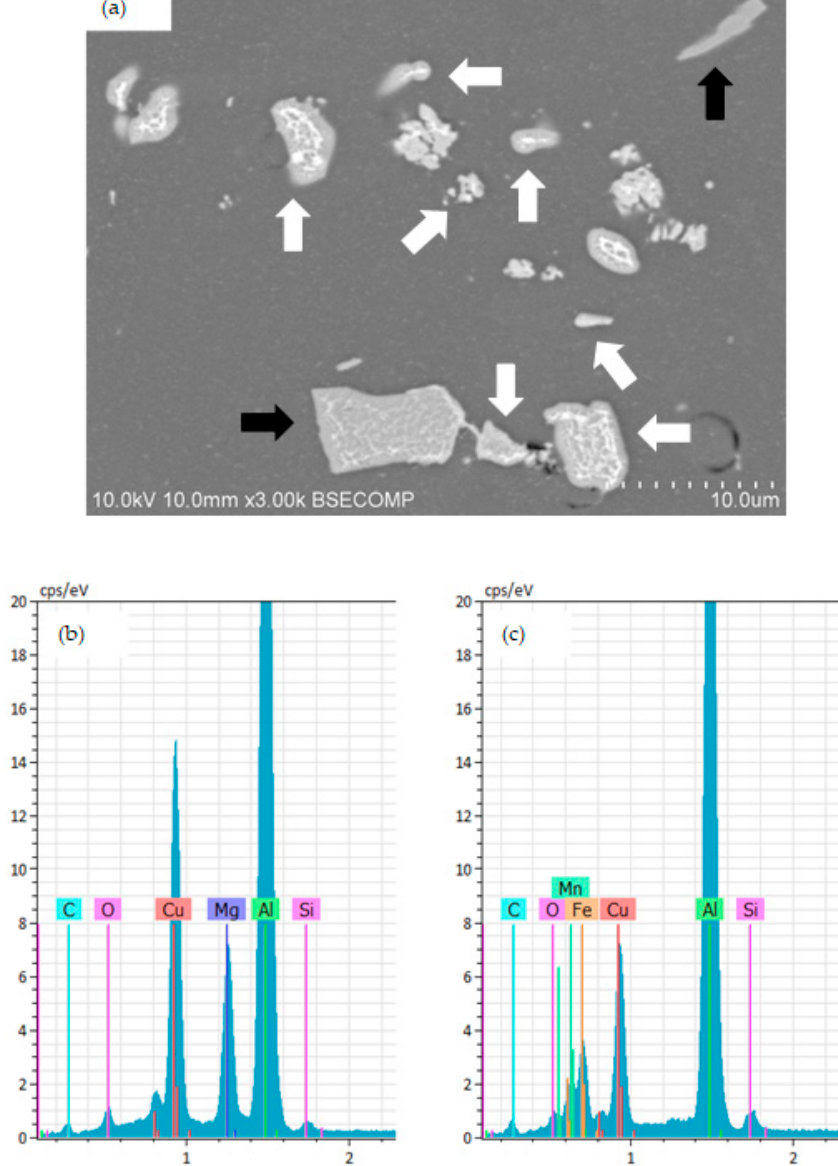
Figure 3. ( a ) SEM image of the main phases identified in alloy AA2024-T3 after Pretreatment 1; ( b ) EDX spectrum of Al(CuMg) particle (white arrows); ( c ) EDX spectrum of Al-Cu-Fe-Mn-(Si) particle (black arrows).